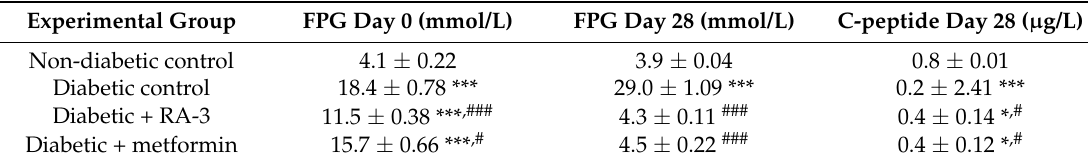
Table 1. The effect of RA-3 on fasting plasma glucose (FPG) and C-peptide levels after the 28 days treatment of the high fat diet and streptozotocin-induced type 2 diabetic rats.